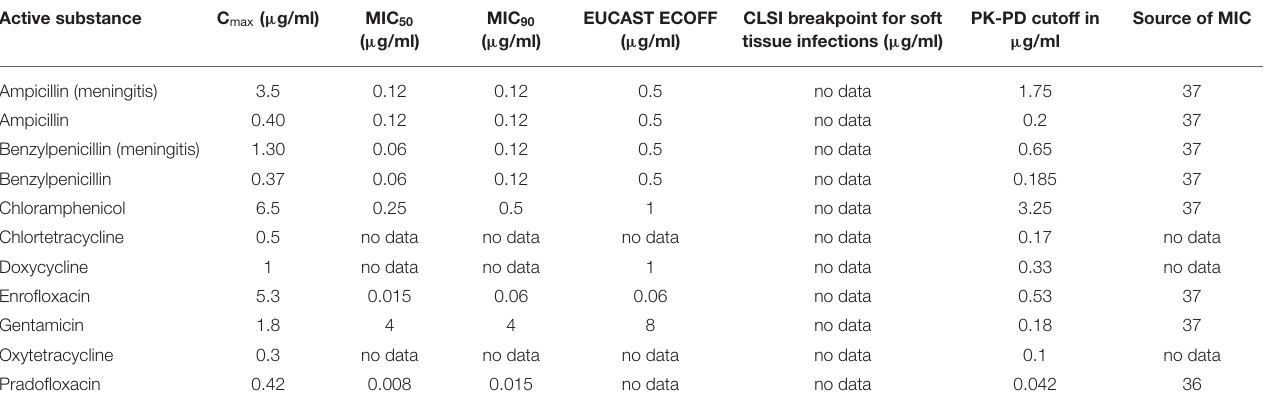
Oxytetracycline